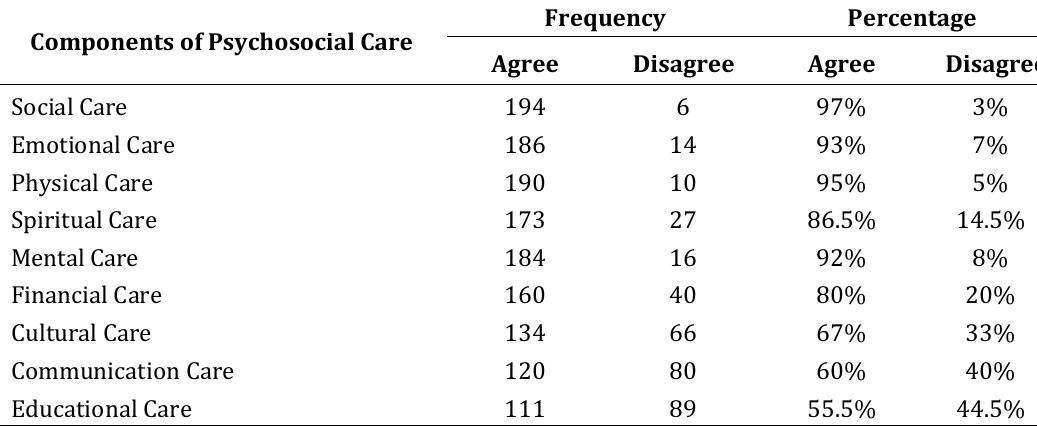
Nurses Knowledge on Components of Psychosocial Care